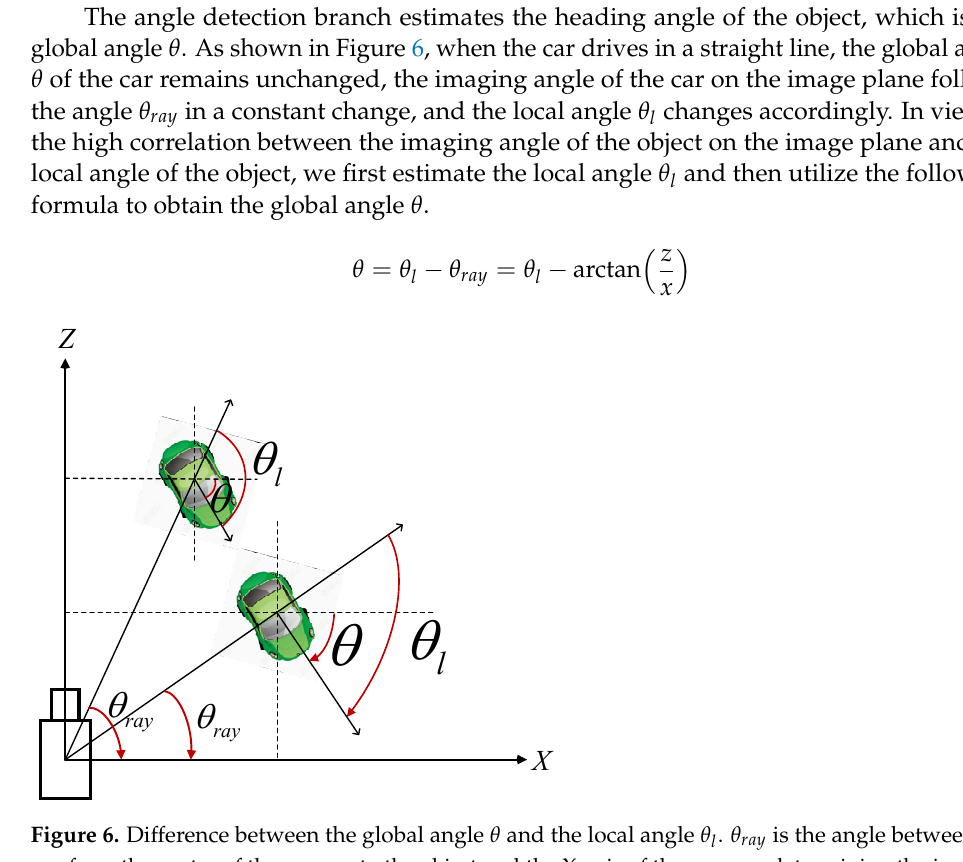
   and the local angle l . ray is the angle between